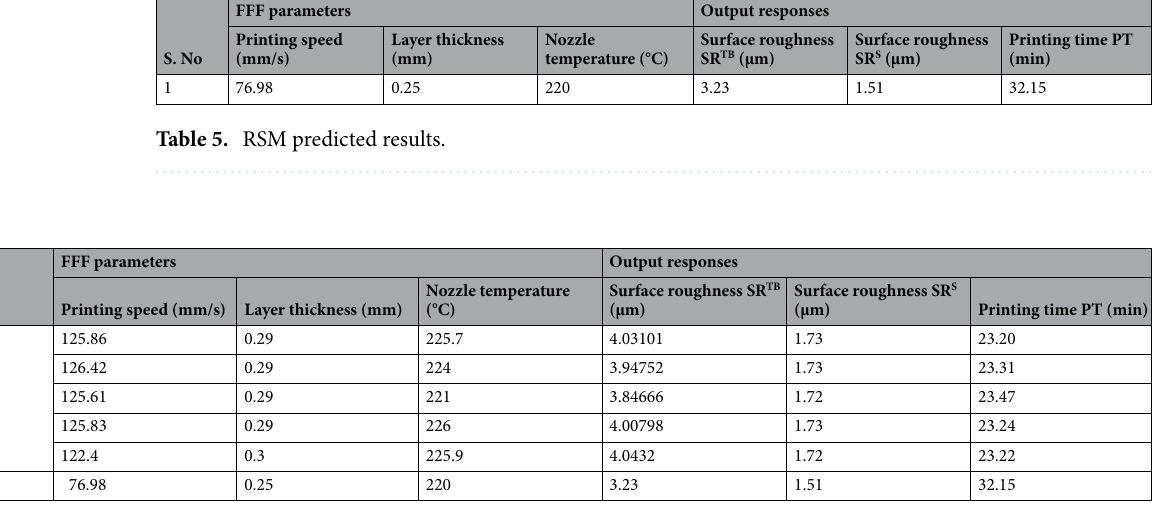
Table 6. RSM and PSO predicted results.